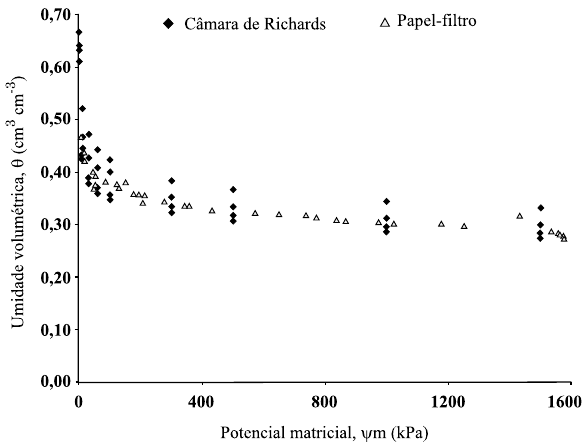
Figura 1. Valores de unidade volumétrica e potencial matricial obtidos com a câmara de pressão de Richards e com o